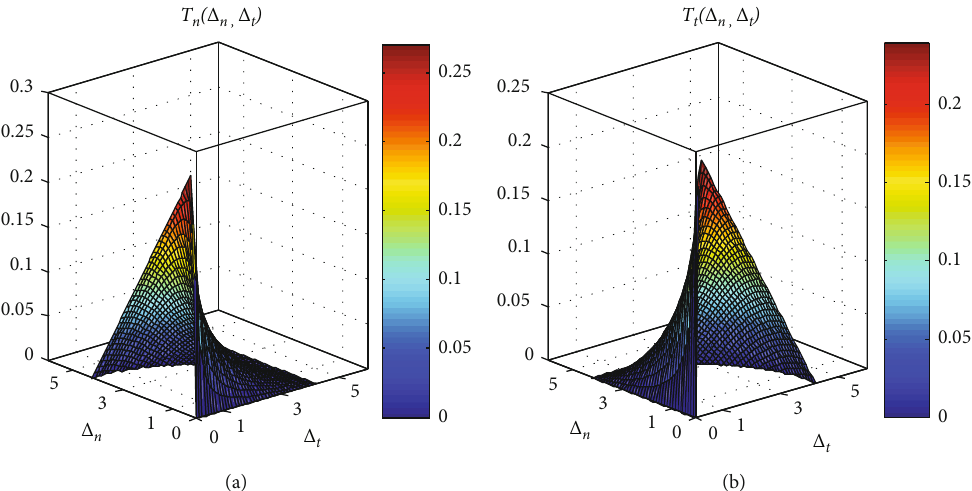
Δ Þ in bilinear CZM in ABAQUS in n , t